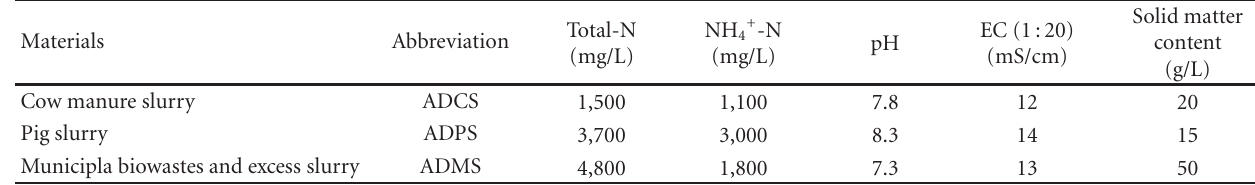
Table 1: Chemical properties of di ff erent types of anaerobically digested